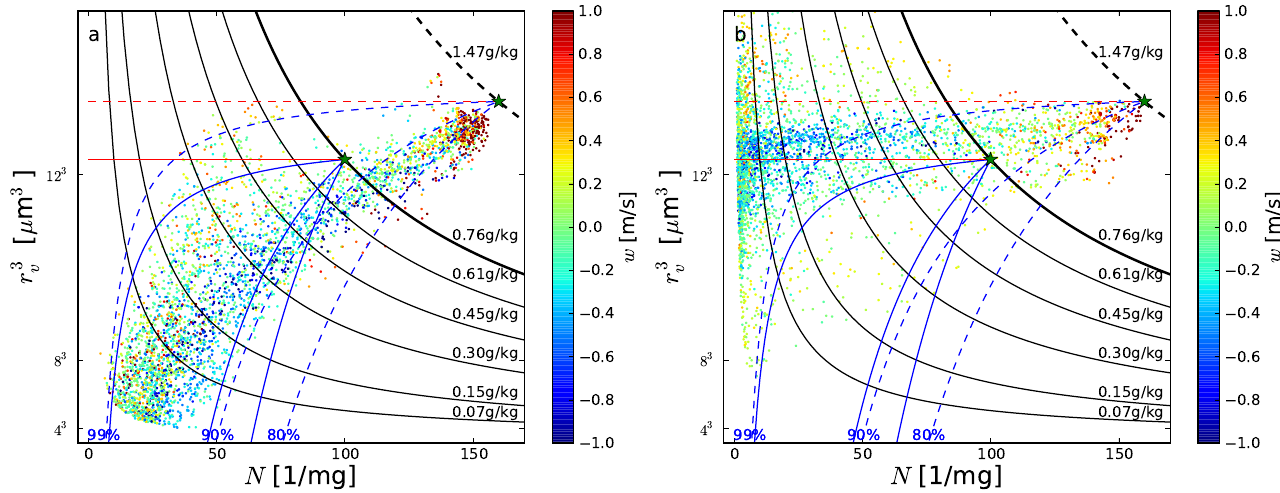
Fig. 17. The N − r 3 v diagrams from simulations applying the standard LES model and at the height of 1200m (i.e., at the stratocumulus top). Panel (a/b) is for the simulation assuming α of 0/1. Black lines show isolines of LWC; the thicker lines represent estimations of the adiabatic LWC. Red lines indicate extremely inhomogeneous mixing and blue lines indicate homogeneous mixing for different relative humidities of entrained air. The starting points for the mixing lines are marked as the green stars. Two starting points are selected to represent the cumuli that penetrate into the stratocumulus layer. Color marks the vertical velocity and the color scale is shown to the right of each